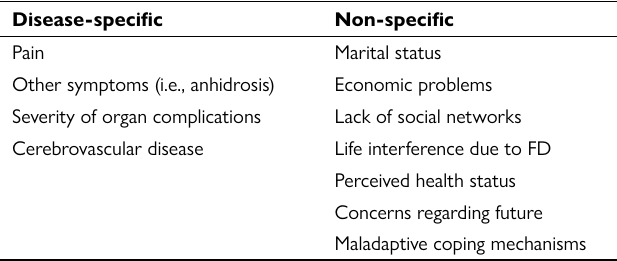
Table 2. Factors associated with depression in patients with Fabry